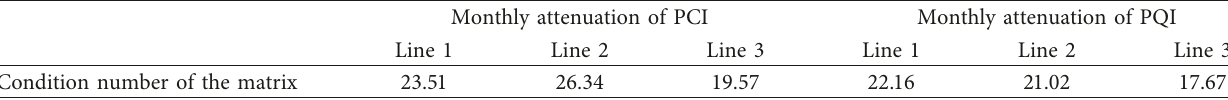
Table 6: Condition number of the GM (1, 1) model matrix using the monthly attenuations of PCI and PQI.